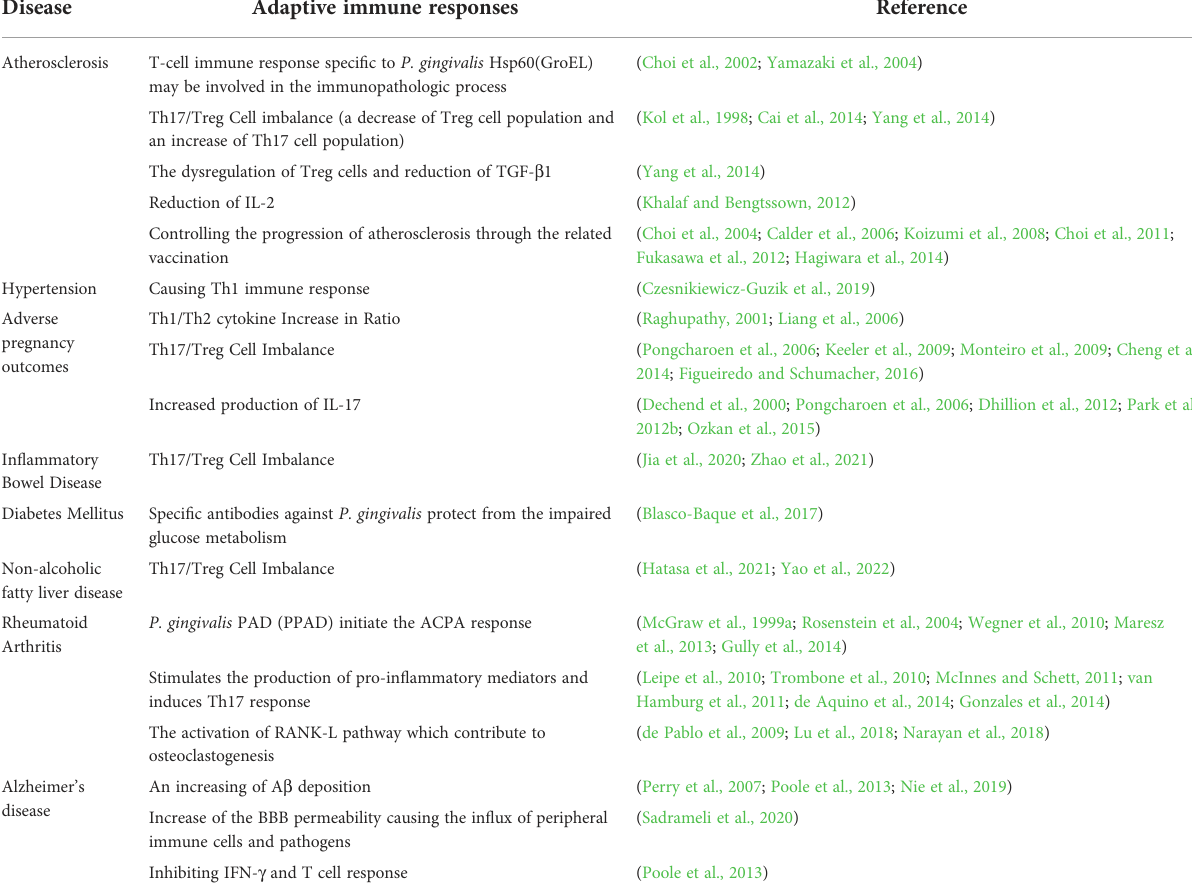
TABLE 1 P. gingivalis -induced adaptive immune responses (mainly mediated by T cells) in various systemic